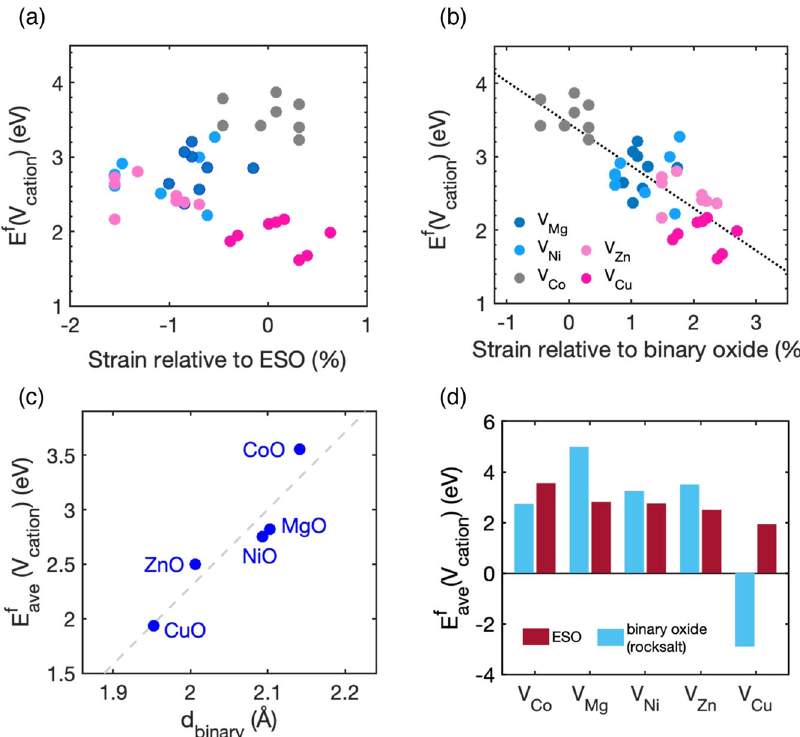
Fig. 1 Local-structure dependence of cation vacancy formation in (Mg 0.2 Ni 0.2 Co 0.2 Cu 0.2 Zn 0.2 )O and comparison with binary oxides. a , b The DFT-calculated formation energies of cation vacancies in (Mg 0.2 Ni 0.2 Co 0.2 Cu 0.2 Zn 0.2 )O as a function of a local strain relative to the average ESO bond length and b local strain relative to the bond length in corresponding binary oxide. The formation energies of cation vacancies decrease with increasing local strain relative to binary oxide. c The average formation energy of cation vacancy in ESO as a function of the average cation-oxygen bond length in corresponding binary oxides showing that the formation of cation vacancy is determined by the shift of the cation-oxygen bond distance from its equilibrium position in the binary oxides. d The comparison between the cation vacancy formation energy for binary oxides and the average cation vacancy formation energy for the